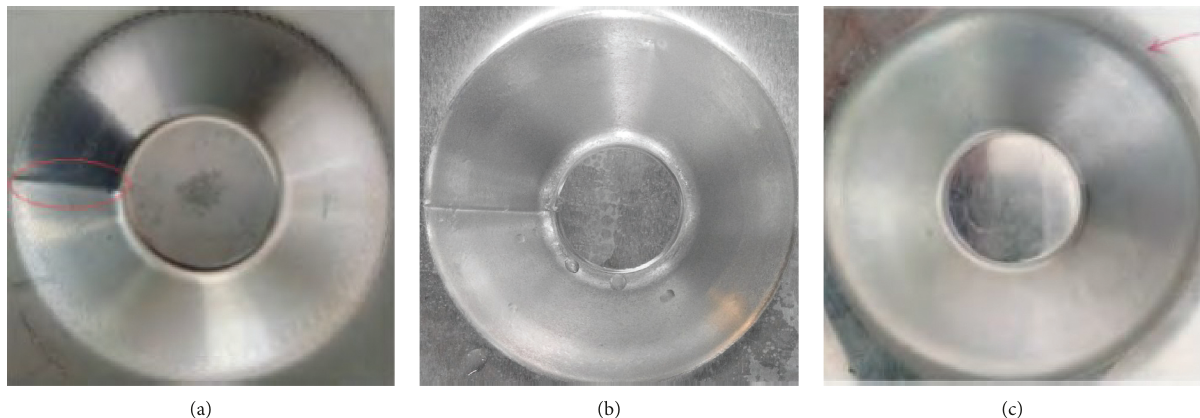
Figure 14: Forming parts of three forming trajectories: (a) single forming trajectory, (b) alternating inversion trajectory, and (c) uniformly press point trajectory.